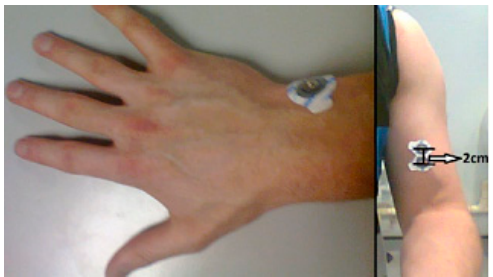
(reference electrode) and the biceps.